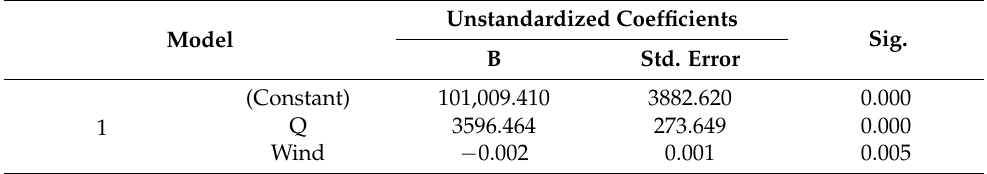
Table 8. Unstandardized coefficients for Q and wind.